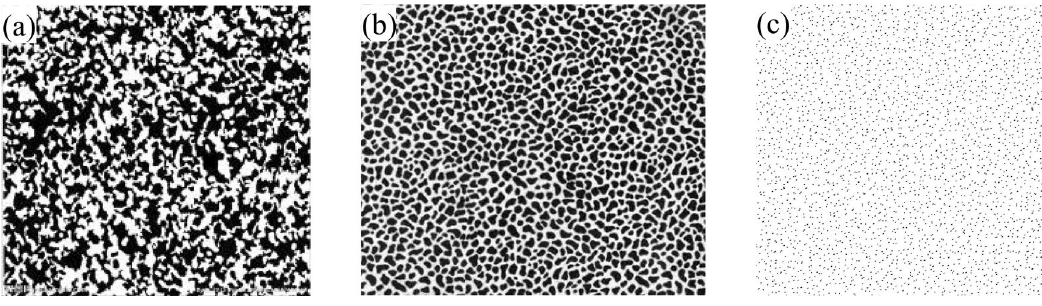
Figure 3. Three typical speckle